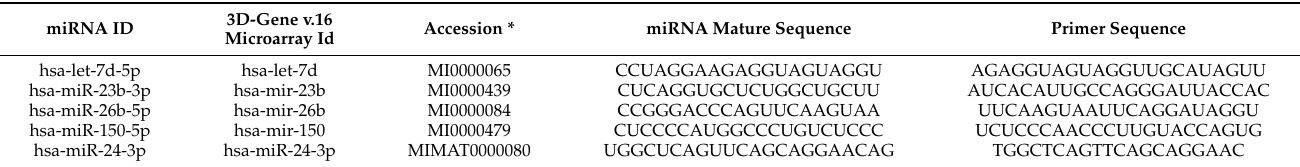
Table 3. Real-time qPCR primers. Primer details of target miRNAs for real-time qPCR.